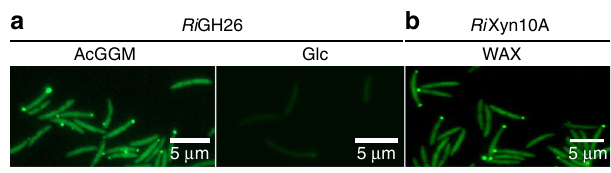
Fig. 3 Cellular location of the endomannanase Ri GH26. a Fluorescent microscopy images of R. intestinalis cells cultured on AcGGM or Glc and